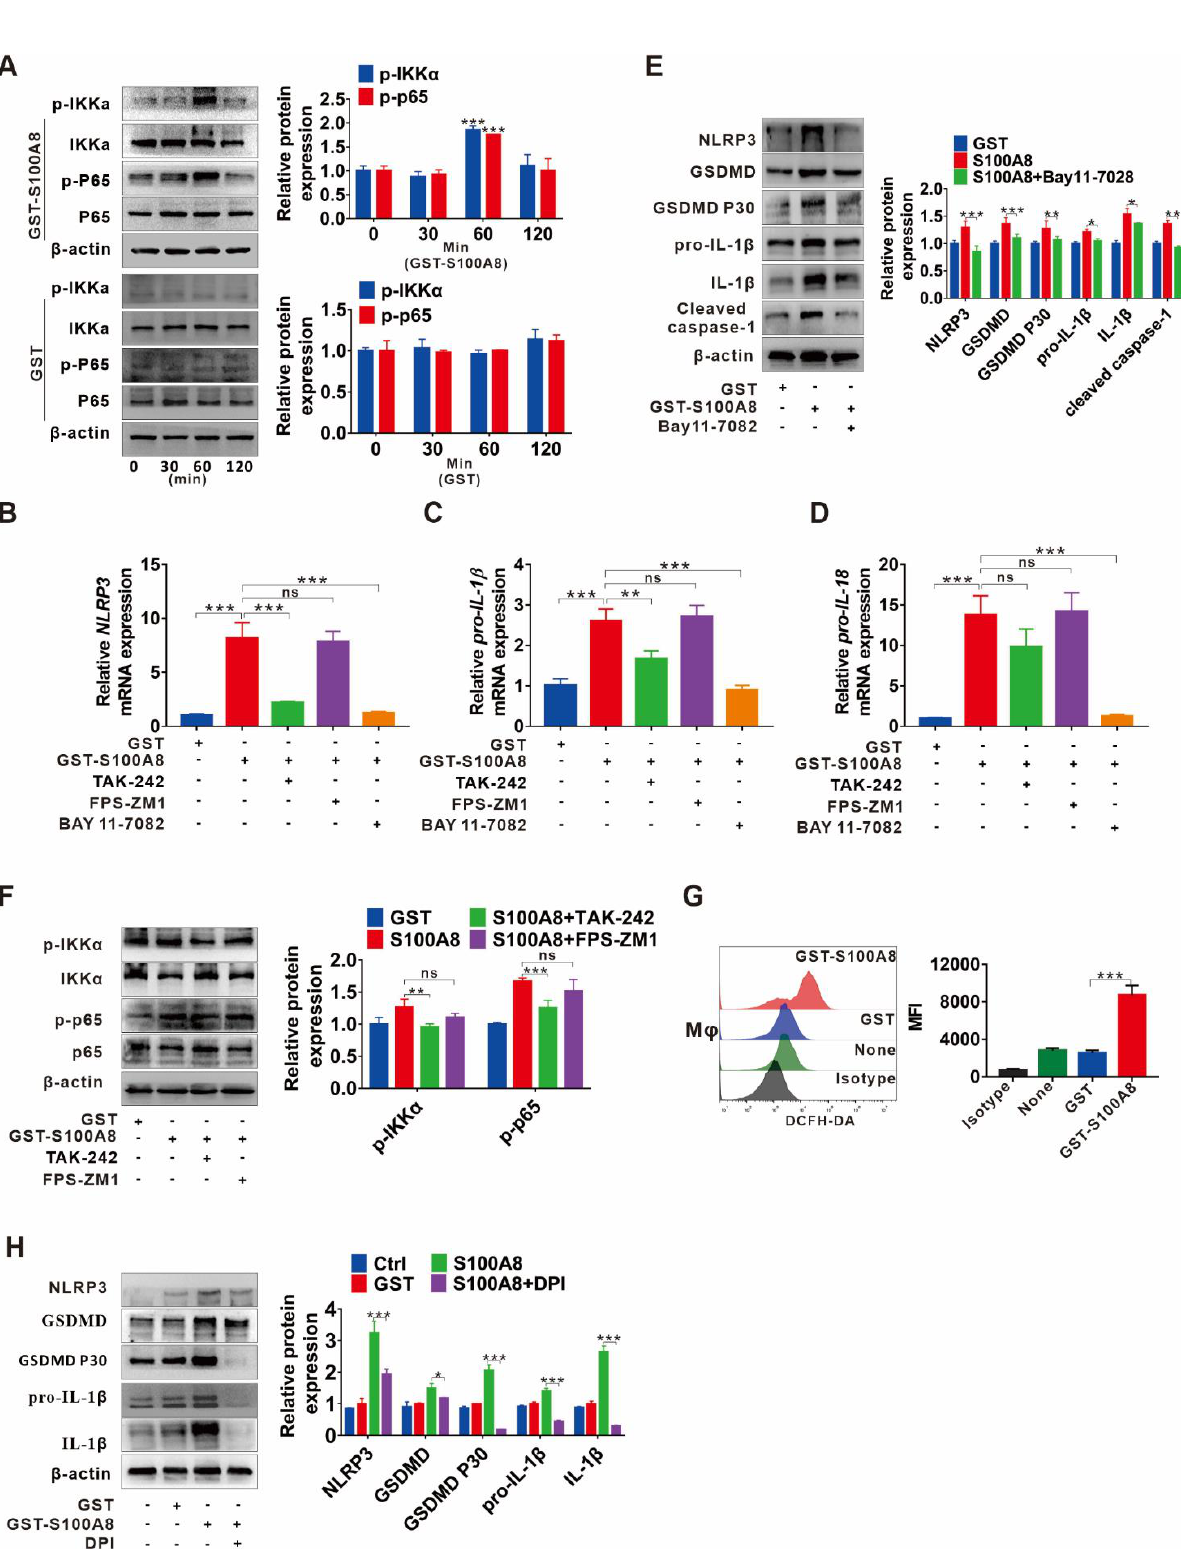
Figure 5 . TLR4/NF- κB signaling cascade and ROS abundance are responsible for S100A8 -induced NLRP3 inflammasome-dependent pyroptotic death in macrophages. (A) Western blot analysis of p65, p- p65, IKKα , and p- IKKα expression in THP -1 macrophages treated with GST-rhS100A8 or GST for 0, 30, 60 or 120 min. The protein expression was quantified by densitometry and normalized to β -actin and are shown as fold changes relative to the 0 min group (right panel). (B – E) THP-1 macrophages were exposed to 5 µg/mL rhS100A8 with or without 1 h of BAY 11-7082, TAK-242 or FPS-ZM1 pretreatment. The qRT-PCR analysis was performed to detect the mRNA levels of NLRP3 (B) , pro-IL- 1β (C) , and pro-IL-18 (D) . Western blot analysis was used to determine the protein expression of NLRP3, GSDMD, GSDMD P30, pro-IL- 1β, mature IL - 1β , and cleaved caspase-1 (E). The protein expression was